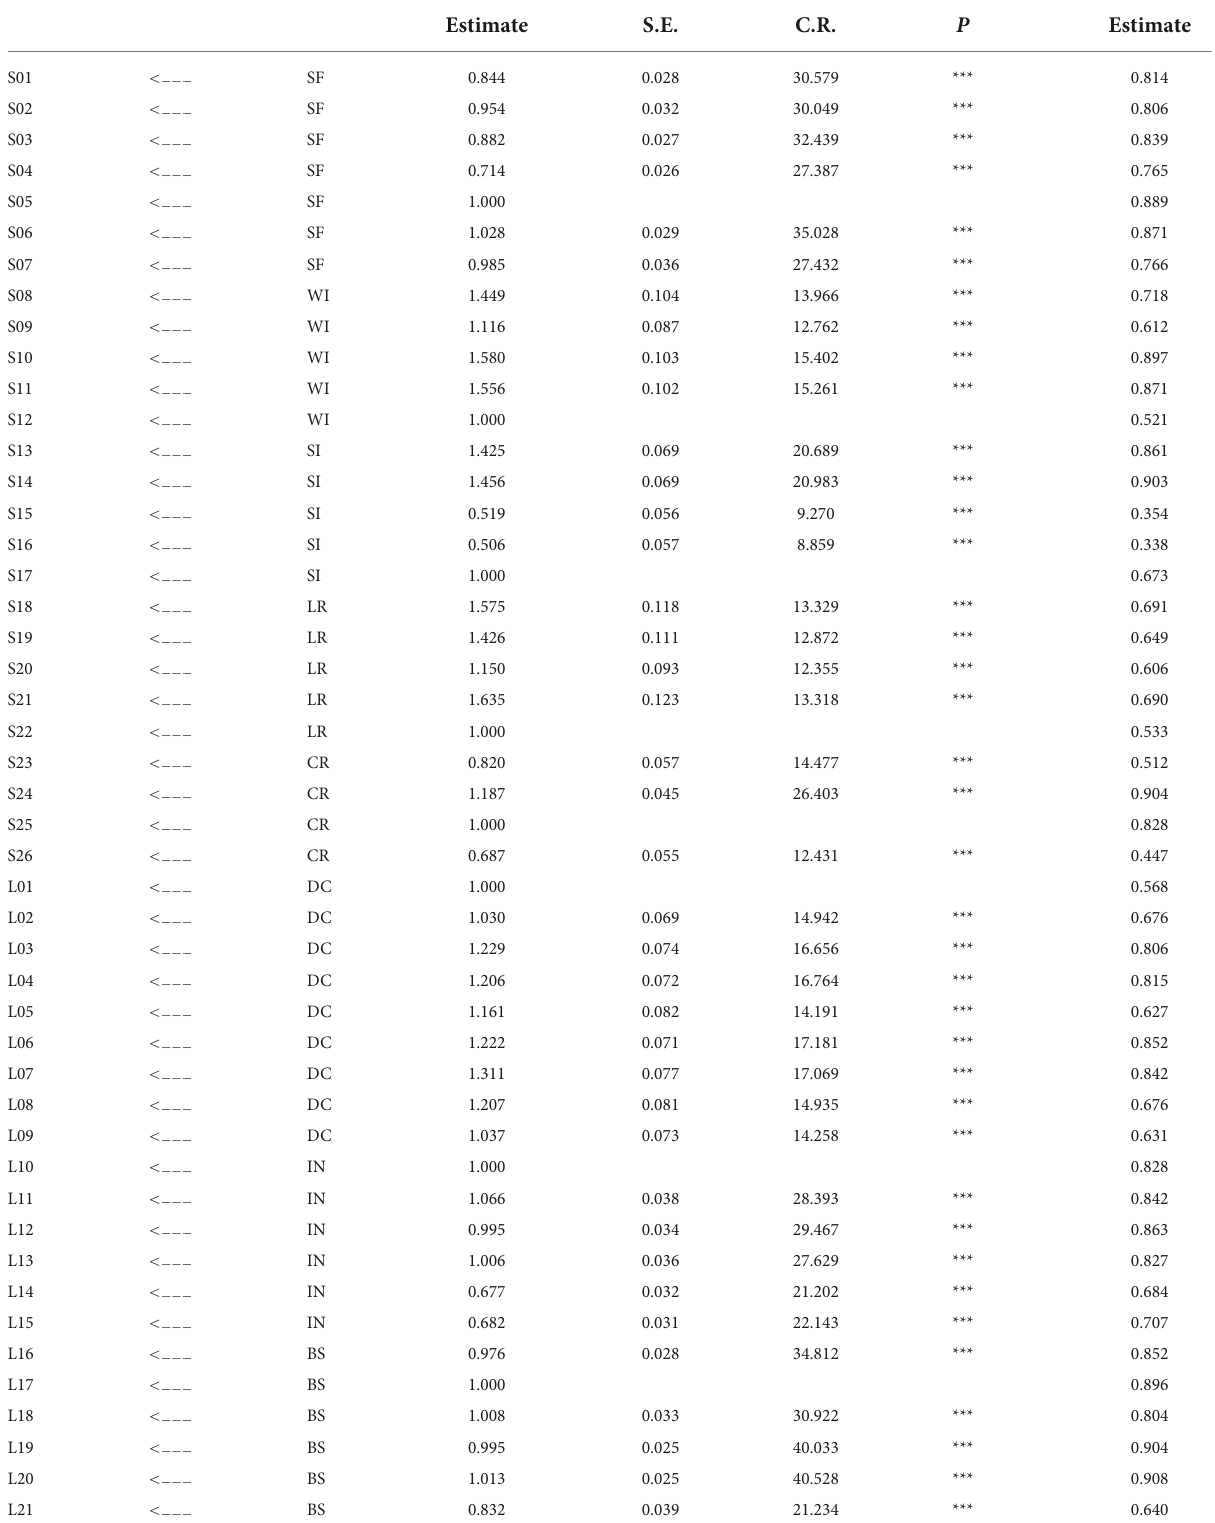
TABLE 2 Unstandardized and standardized estimates of the initial CFA model. Unstandardized Standardized Estimate